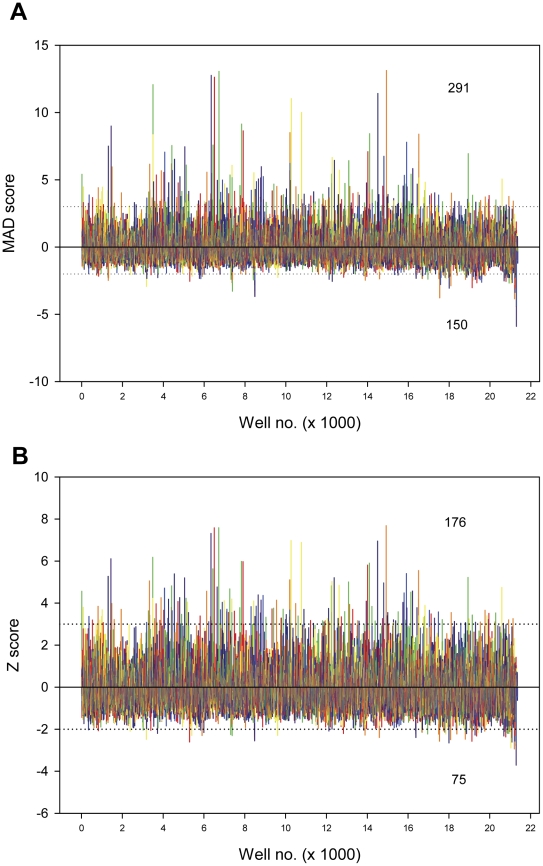
Distribution of β-gal assay signal in the genome wide RNAi screen.
A) Luminescence intensity measurements of the genome wide RNA screen of 21125 wells in triplicates were processed by MAD score analysis method and the results are plotted against well numbers. Horizontal dotted lines indicate the hit selection criteria of +3 MAD or −2MAD. The two numbers listed in the plot represent the total number of hits that meet the two selection criteria. B) Luminescence intensity measurements in triplicates were processed by Z score analysis method and the results are plotted against well numbers. Horizontal dotted lines indicate the hit selection criteria of +3 SD or −2SD. The numbers listed in the plot represent the total number of hits that meet the hit selection criteria.